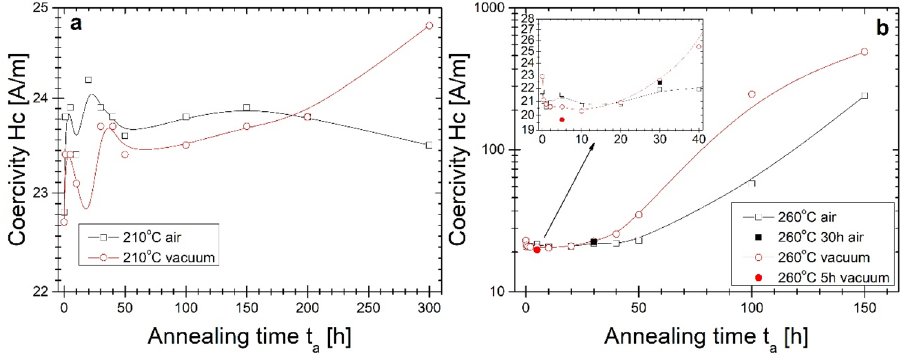
Figure 8. Coercivity on the annealing time of the isothermal process at ( a ) 210 °C and ( b ) 260 °C.